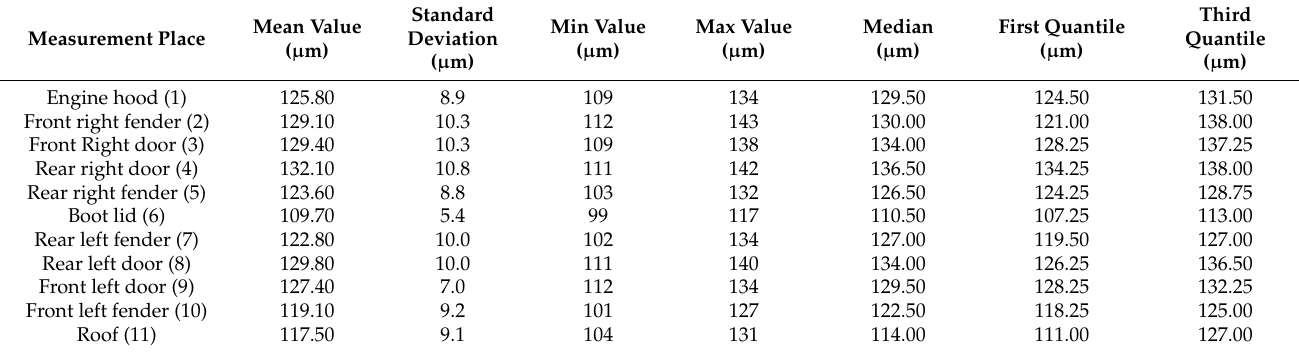
Table 2. The results of the measurements of the coating thickness of the delivery vehicle.